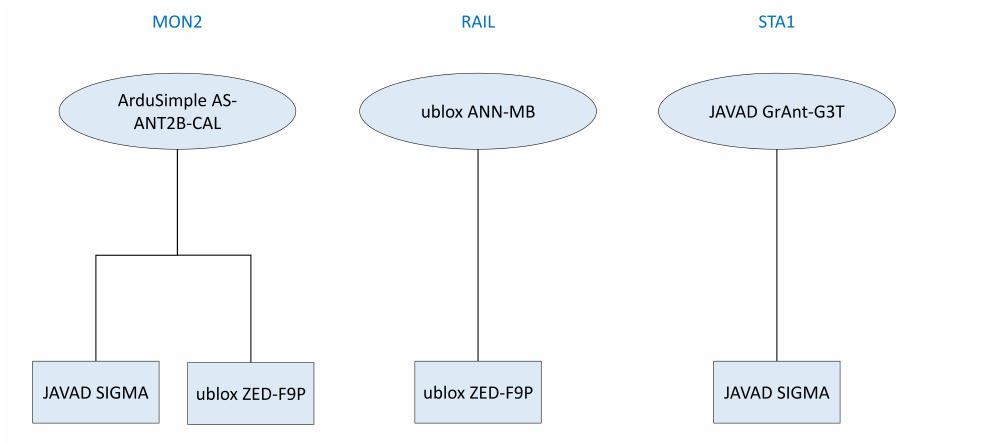
Figure 5. Session 2: receiver and antenna combinations for the experimental